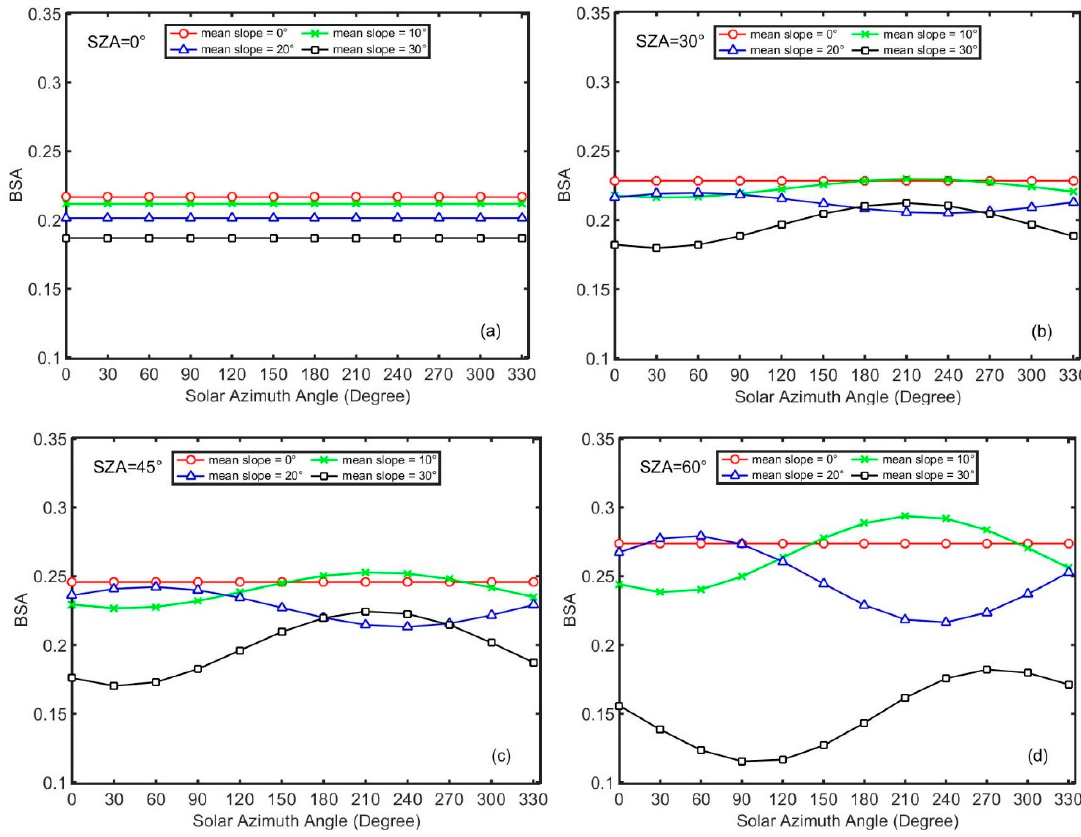
Figure 11. BSA variations with the SAA under different SZAs: ( a ) 0°; ( b ) 30°; ( c ) 45°; and ( d ) 60°.